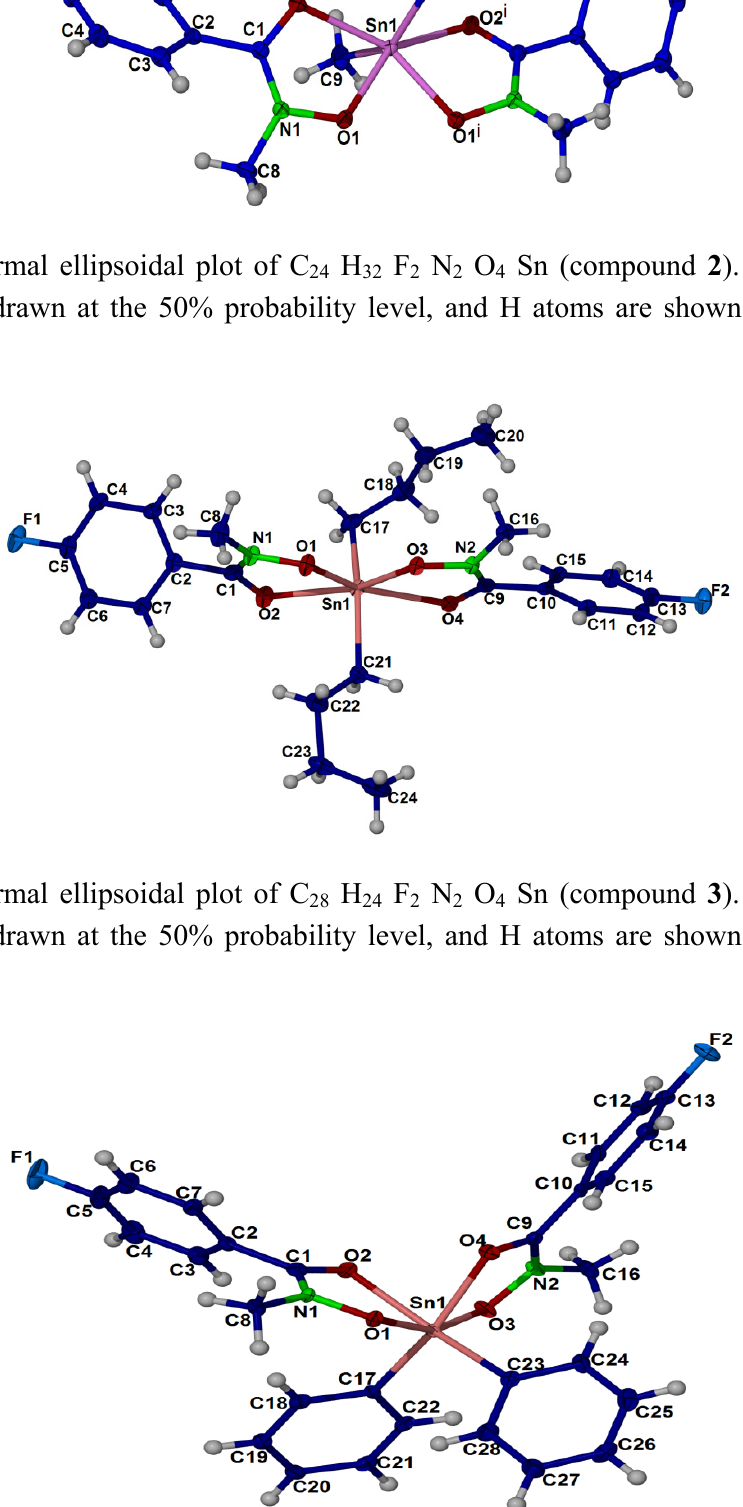
Figure 1. Thermal ellipsoidal plot of C ellipsoids are drawn at the 50% probability level, and H atoms are shown as spheres of arbitrary radii. Symmetry transformation code i: − x + 1,y, − z + 3/2.